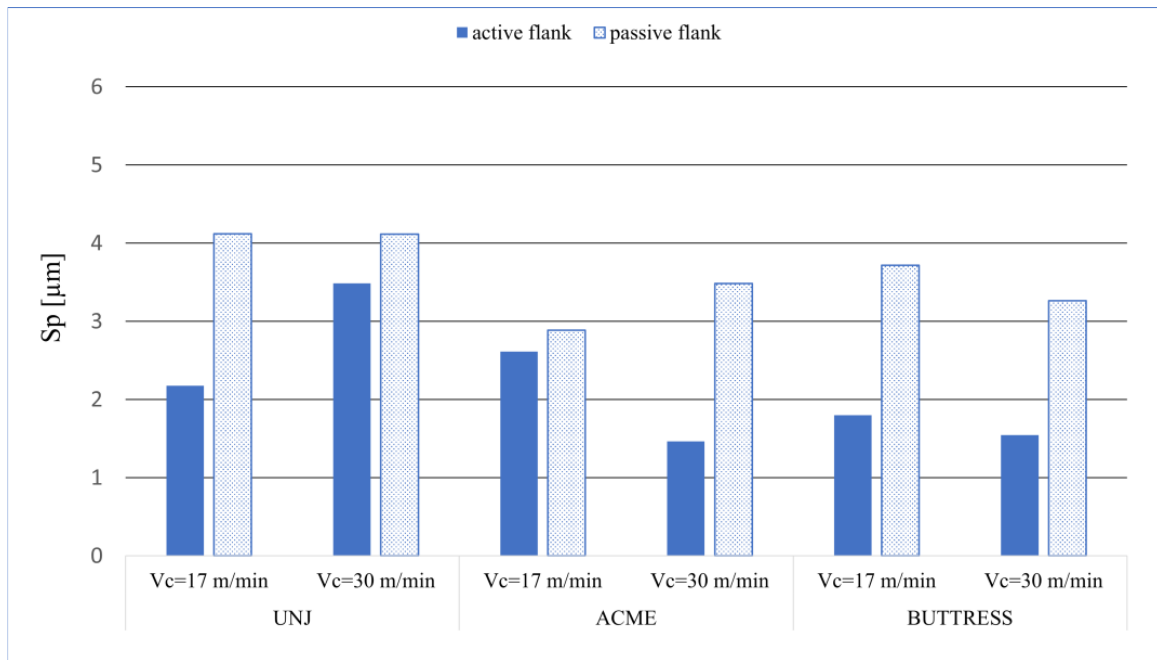
Figure 7. Sp values for the measured surfaces.